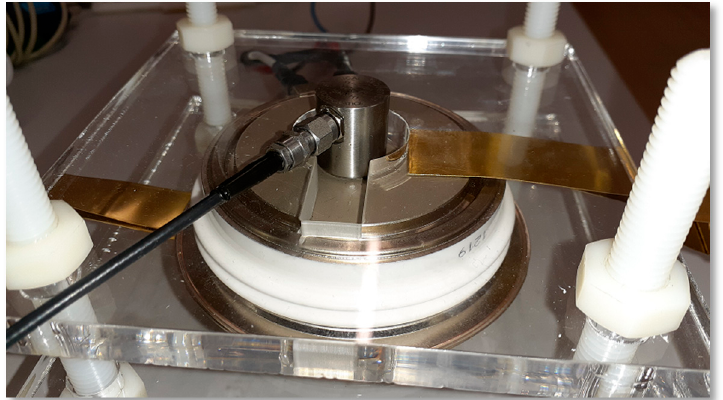
Figure 4. The acoustic emission sensor in the metal case placed on the GTO.